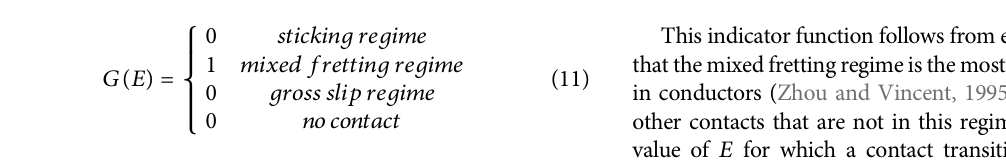
Frontiers in Built Environment |